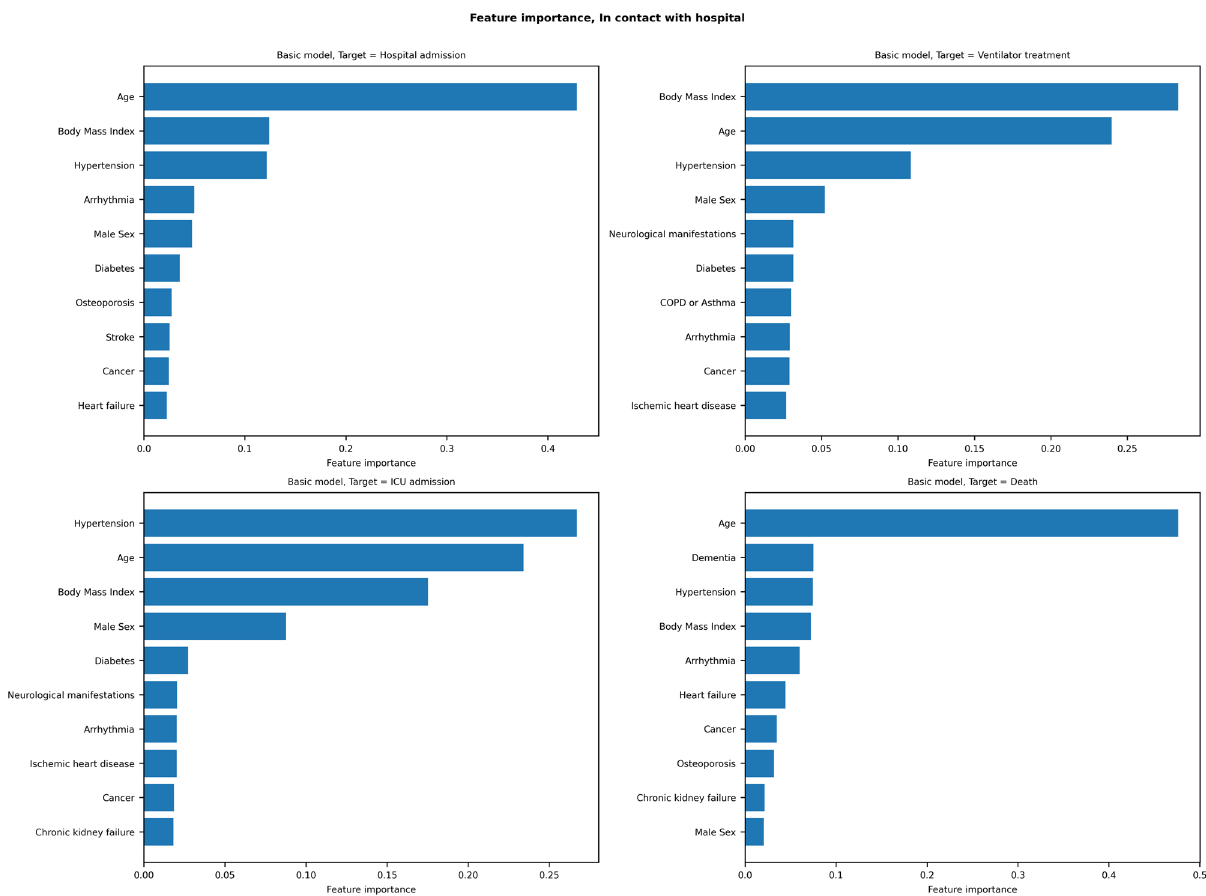
Figure 2. Feature importance for the basic (including age, sex, body mass index, and comorbidities) diagnosis models, predicting risk of intensive care admission (first row), hospital admission (second row), ventilator treatment (third row) and death (fourth row) on SARS-CoV-2